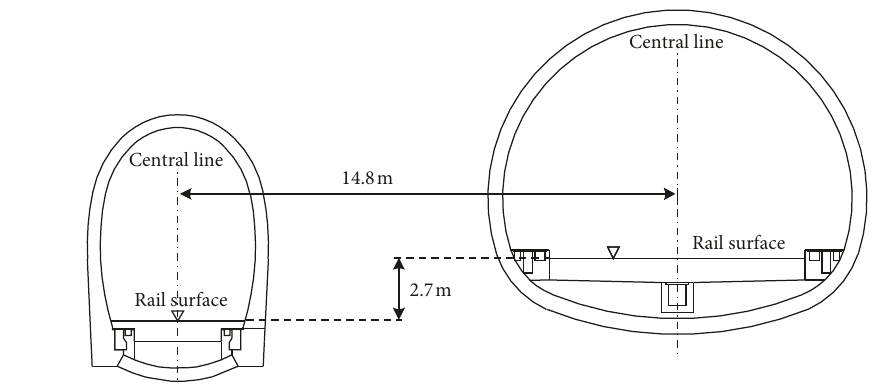
Figure 4: Spacing between two tunnels. Table 1: Management standard of geometric irregularity